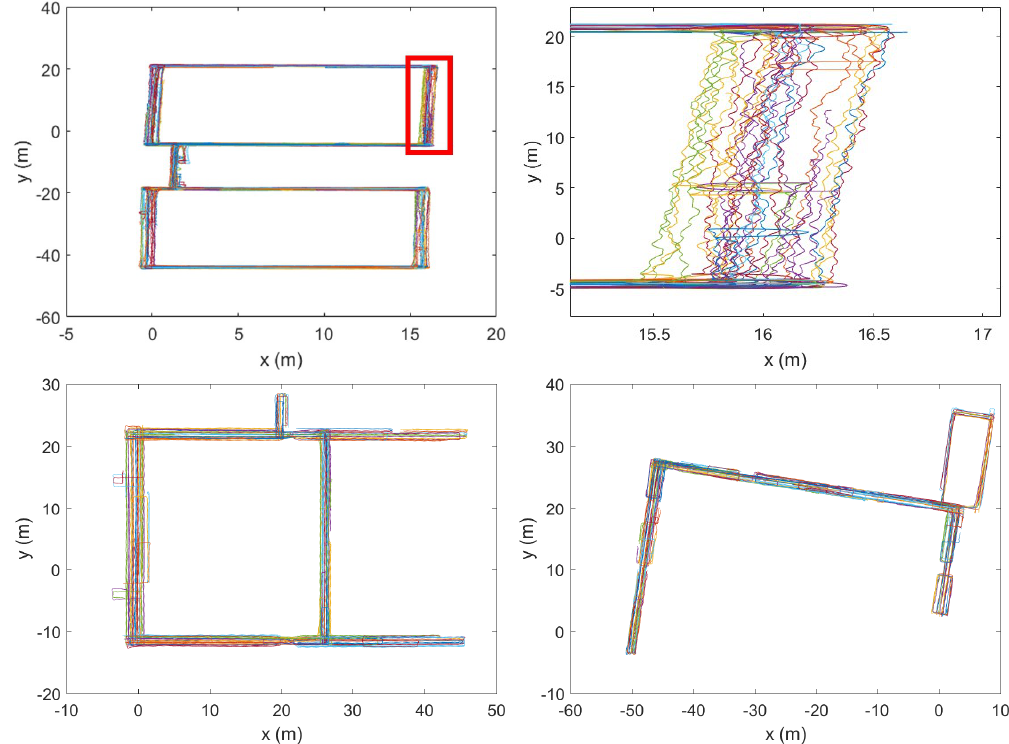
Figure 6. Ground-truth trajectories in three buildings: CSL ( top left ), part of CSL magnified ( top right ), Loomis ( bottom left ), and Talbot ( bottom right ) in the Illinois traces